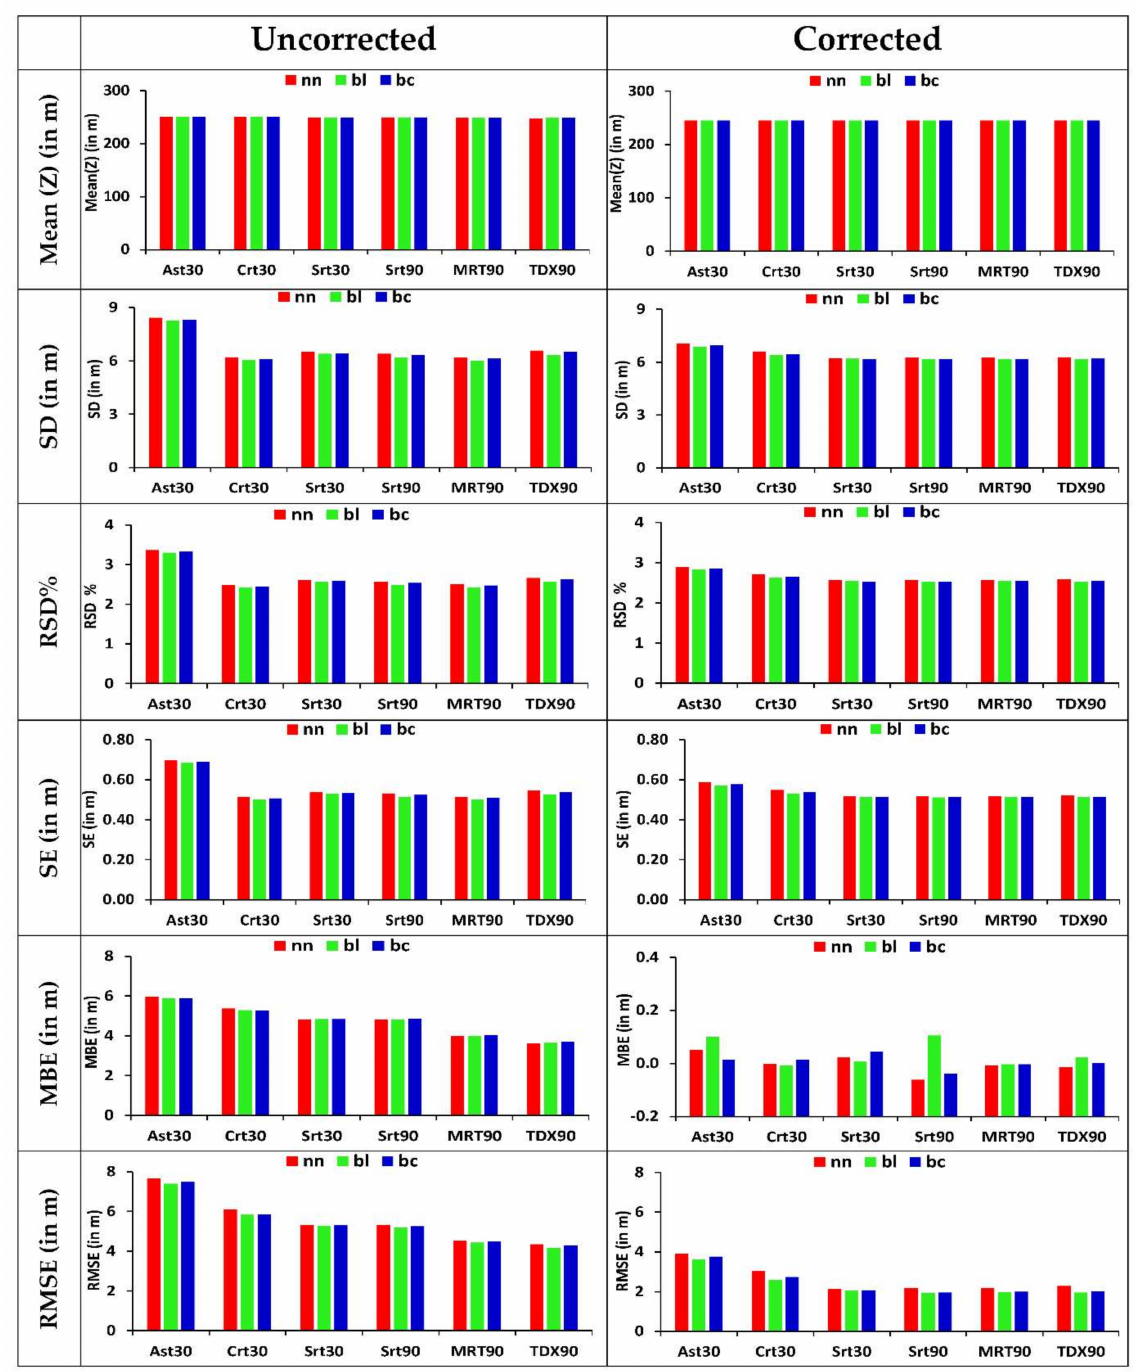
Figure 4. Statistical measures (mean, standard deviation (SD), relative standard deviation (RSD), standard error (SE), mean bias error (MBE), and root-mean-square error (RMSE)) cal- culated for uncorrected and corrected space-borne elevation datasets (Ast30 = ASTER GDEM V3, Crt30 = CartoDEM v3.R1, Srt30 = SRTM.v3, Srt90 = SRTM.v4.1, MRT90 = MERIT DEM, TDX90 = TanDEM-X 90 m) show significant decreases in MBE and RMSE after correction. The nn, bl, and bc refer to the interpolation